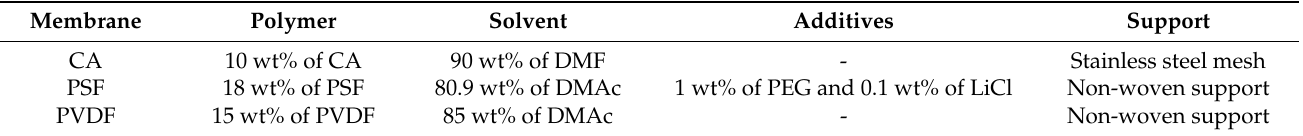
Table 1. Summary of materials and weight percentage in membranes evaluated in this study. Membrane Polymer Solvent Additives Support CA 10 wt% of CA 90 wt% of DMF - Stainless steel mesh PSF 18 wt% of PSF 80.9 wt% of DMAc 1 wt% of PEG and 0.1 wt% of LiCl Non-woven support PVDF 15 wt% of PVDF 85 wt% of DMAc - Non-woven